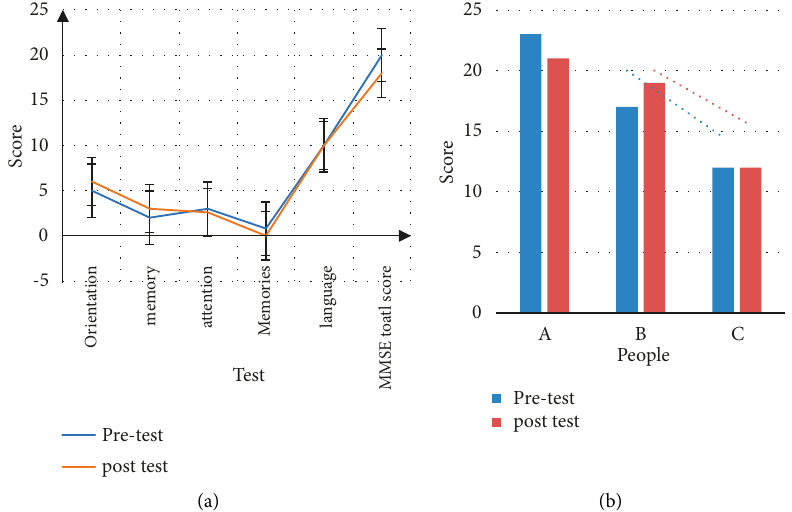
Figure 10: GDS-15 total score and GDS-15 scale total score. (a) GDS-15 total score and comparison of each subitem before and after the test. (b) GDS-15 total score of 3